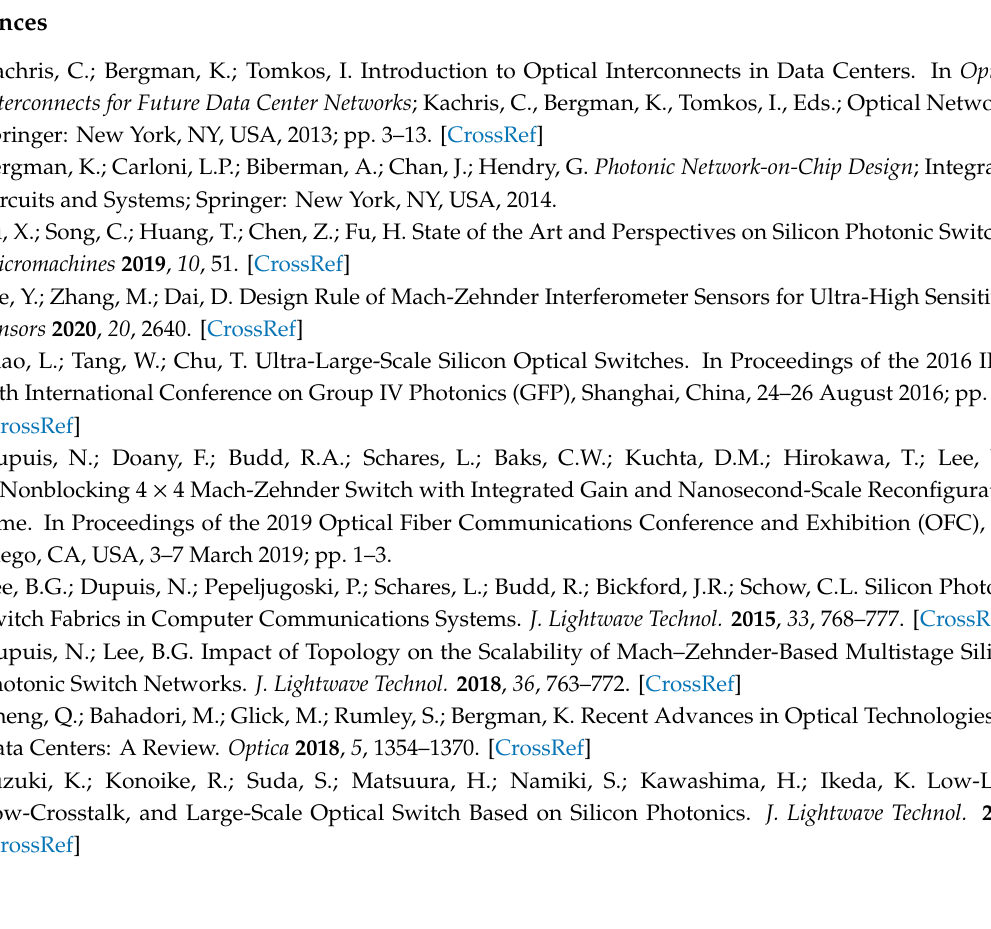
Figure A4. ˆ SCR values of Bene s considering Loss X = 0.2 dB , the solid blue curve. Black square dots are the simulation Figure A4. (cid:1845)(cid:1829)(cid:1844)(cid:3554) values of Beneš considering (cid:1838)(cid:1867)(cid:1871)(cid:1871) (cid:3025) = 0.2 (cid:1856)(cid:1828) , the solid blue curve. Black square dots are the simulation results.